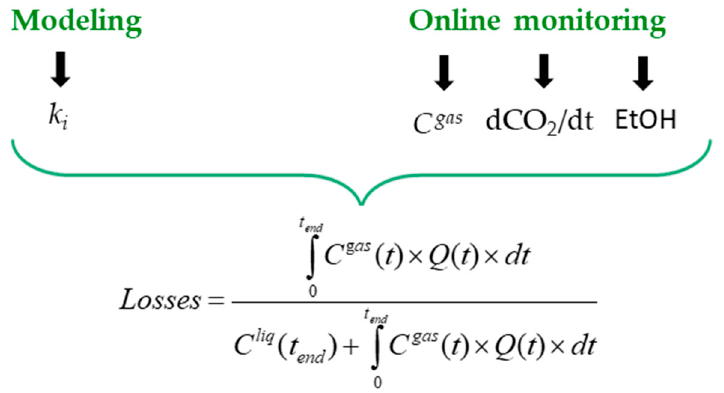
Figure 2. Calculation of the overall losses of a volatile compound in the exhaust gas from (i) online monitoring of the fermentation kinetics (dCO 2 /dt and EtOH) and concentration of the volatile com- pound in the gas phase (C gas) ) and (ii) the modelling of the gas–liquid equilibrium coefficient (k i ). Q(t)is the CO 2 production rate (per liter of must) and C liq (t) the concentration of the volatile com- pound in the liquid phase [6].